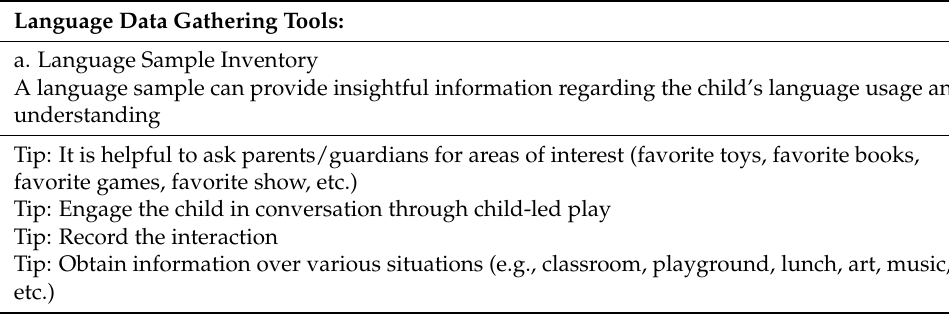
Table 7. Language Data Gathering